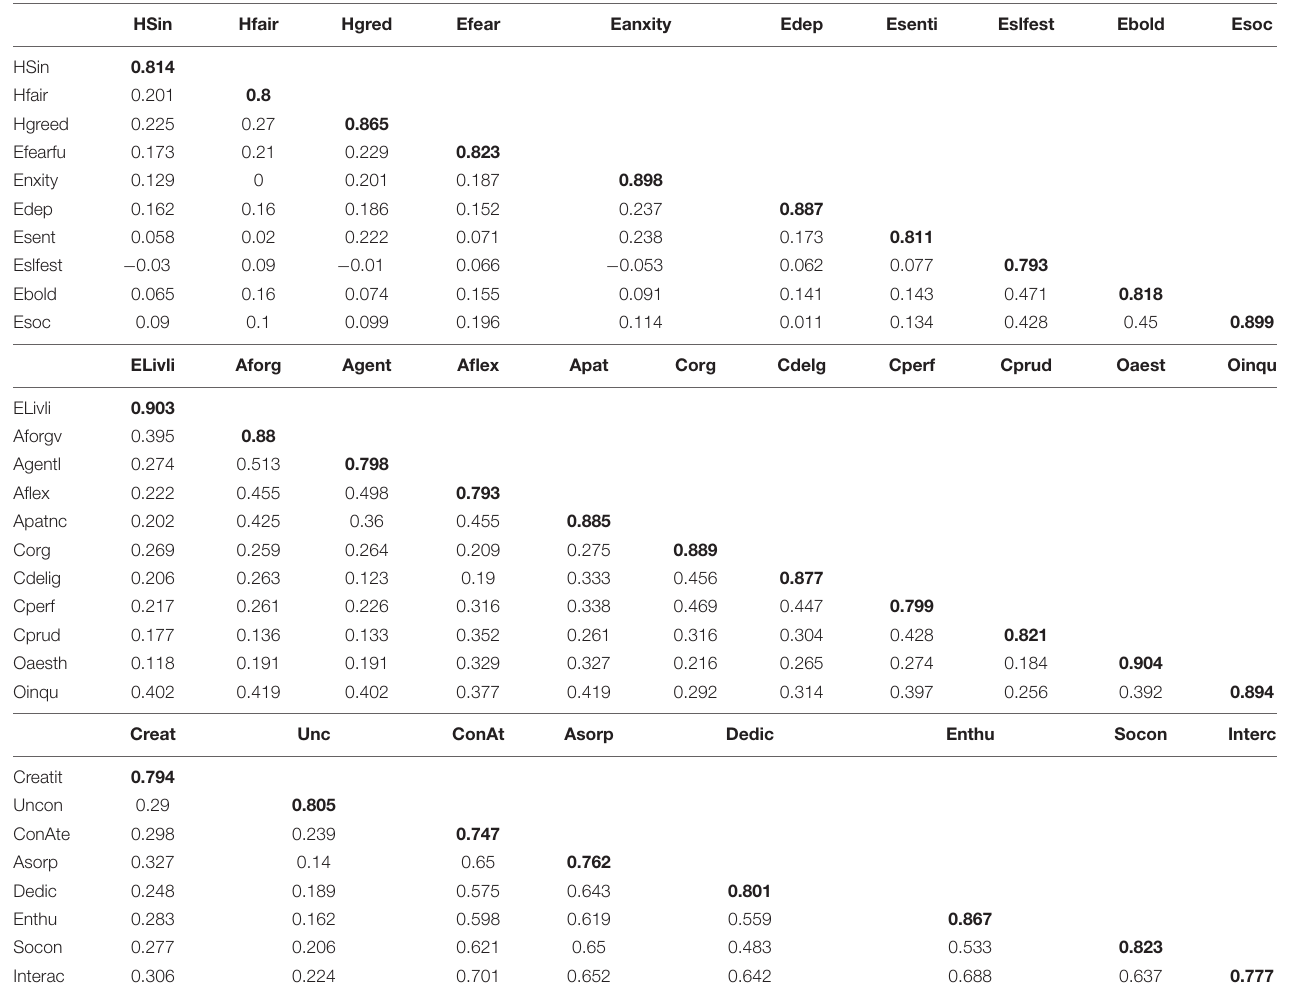
TABLE 3 | Discriminant